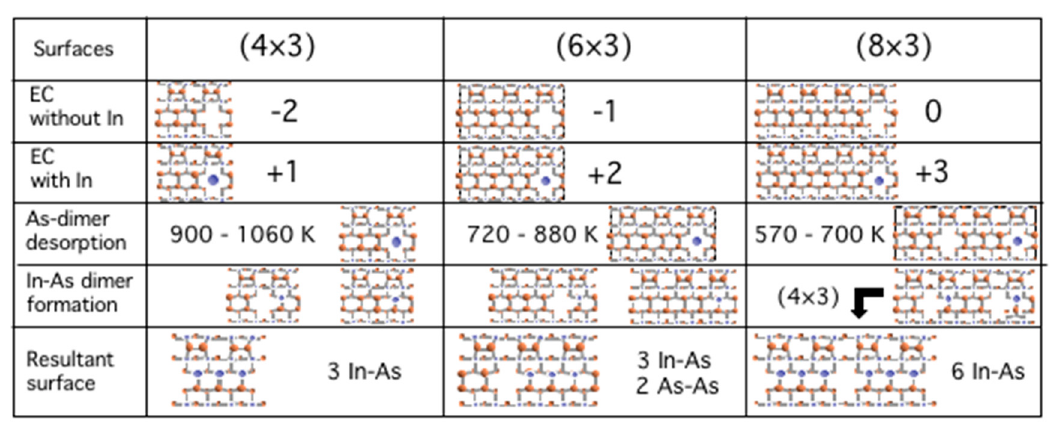
Figure 10. Summary of the growth processes on the ( n × 3) surfaces obtained in this study.